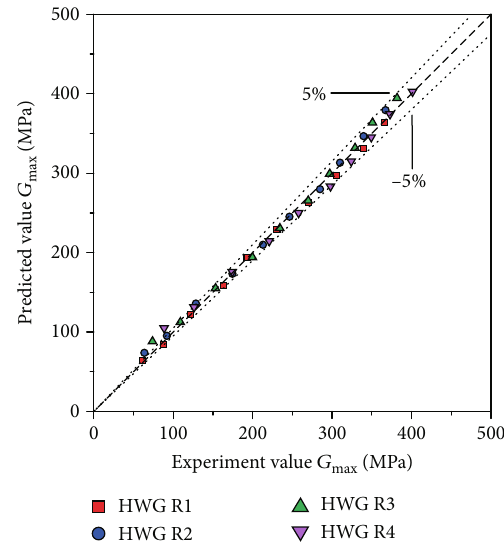
Figure 9: Relationships of measured G using the model modi fi ed by the initial dry